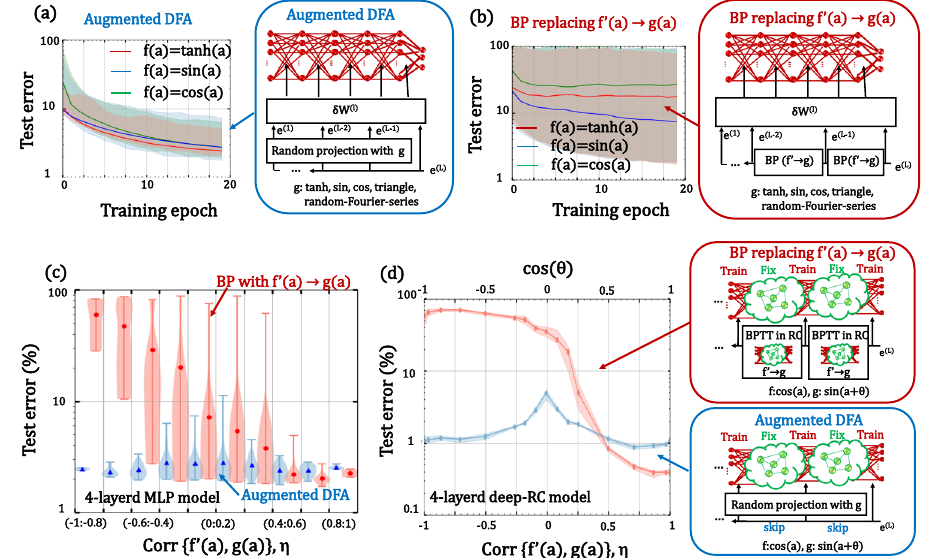
Fig. 2 | BP vs augmented DFA. Training curve of 4-layer MLP with 800 hidden nodes for a augmented DFA and b BP with various g( a ):sin( a ), cos( a ), triangle( a ), tanh( a ) functions, and 40 random Fourier series. Color differences indicate dif- ferences in activation function [ f ( a )=sin( a ), cos( a ), tanh( a )]. Bold line and shaded areaindicatetheaverageandmaximum-minimumregion,respectively. c Testerror distribution of four-layer fully connected neural network as a function of the cor- relation coef fi cients between f ’ ( a ) and g ( a ), η . Blue and red boxplots in c are the results for the model trained by BP and augmented DFA, respectively. η was scanned by using various g ( a ):sin( a ), cos( a ), triangle( a ), tanh( a ) functions and a random Fourier series. The whiskers, plots, and fi lled area show the minimum and